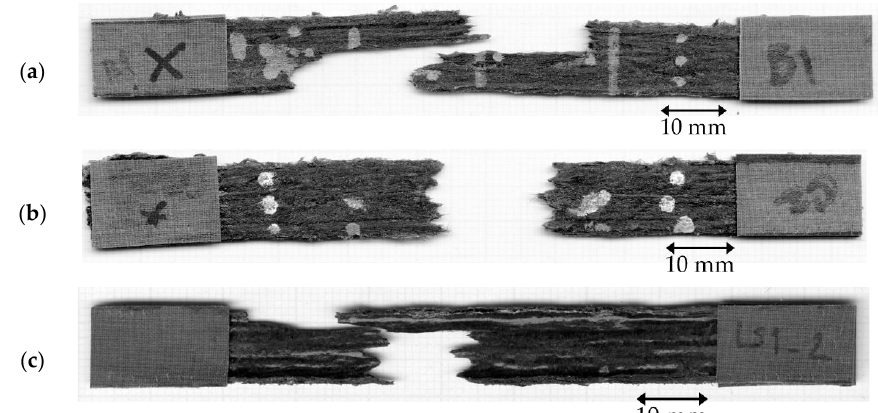
Figure 6. Breakage sample of tensile sample: ( a ) inter-raster failure parallel to the load direction; ( b ) favourable failure perpendicular to the load direction showing the load transfer to the fibre direction; ( c ) breakage of the oven-treated sample showing the breakage parallel to the raster direction. Table 2. Tensile properties comparison of the current DcAFF samples to the previous studies. To compare the performance of the DcAFF (HiPerDiF-PLA) 3D printed part with other available 3D printing materials from literature, the tensile stiffness and strength of the